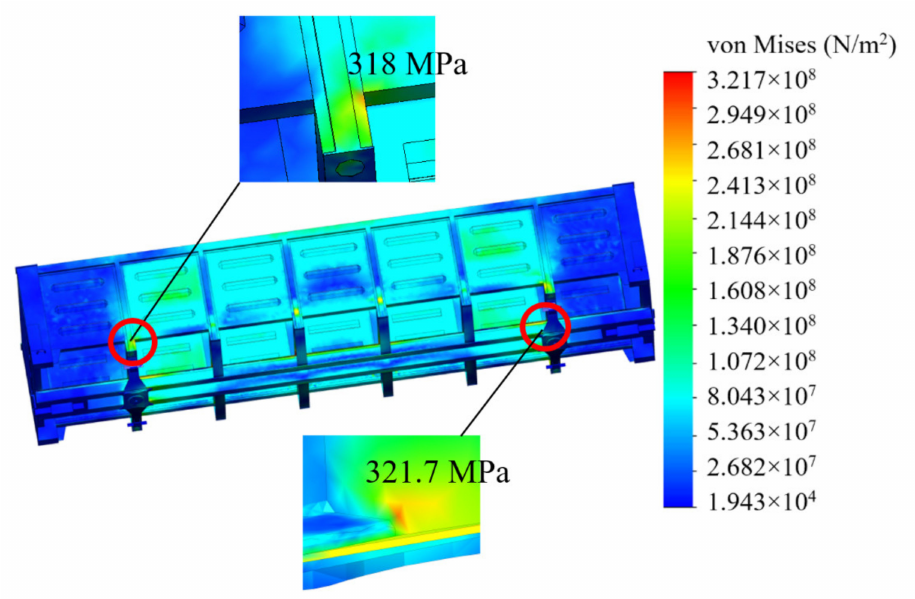
Figure 9. Stress strain state of the bearing structure of an open car body during impact interaction with a grab.